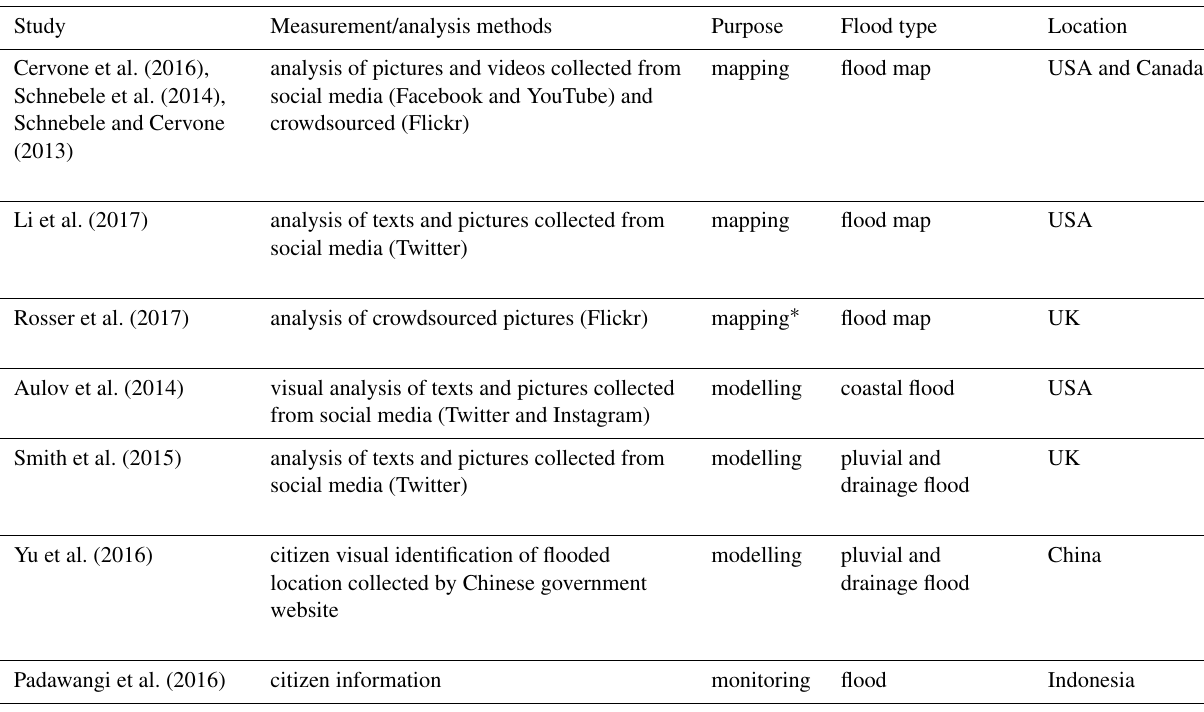
Table 3. Scientific literature on citizen contributions to measurement and analysis of flood extent.